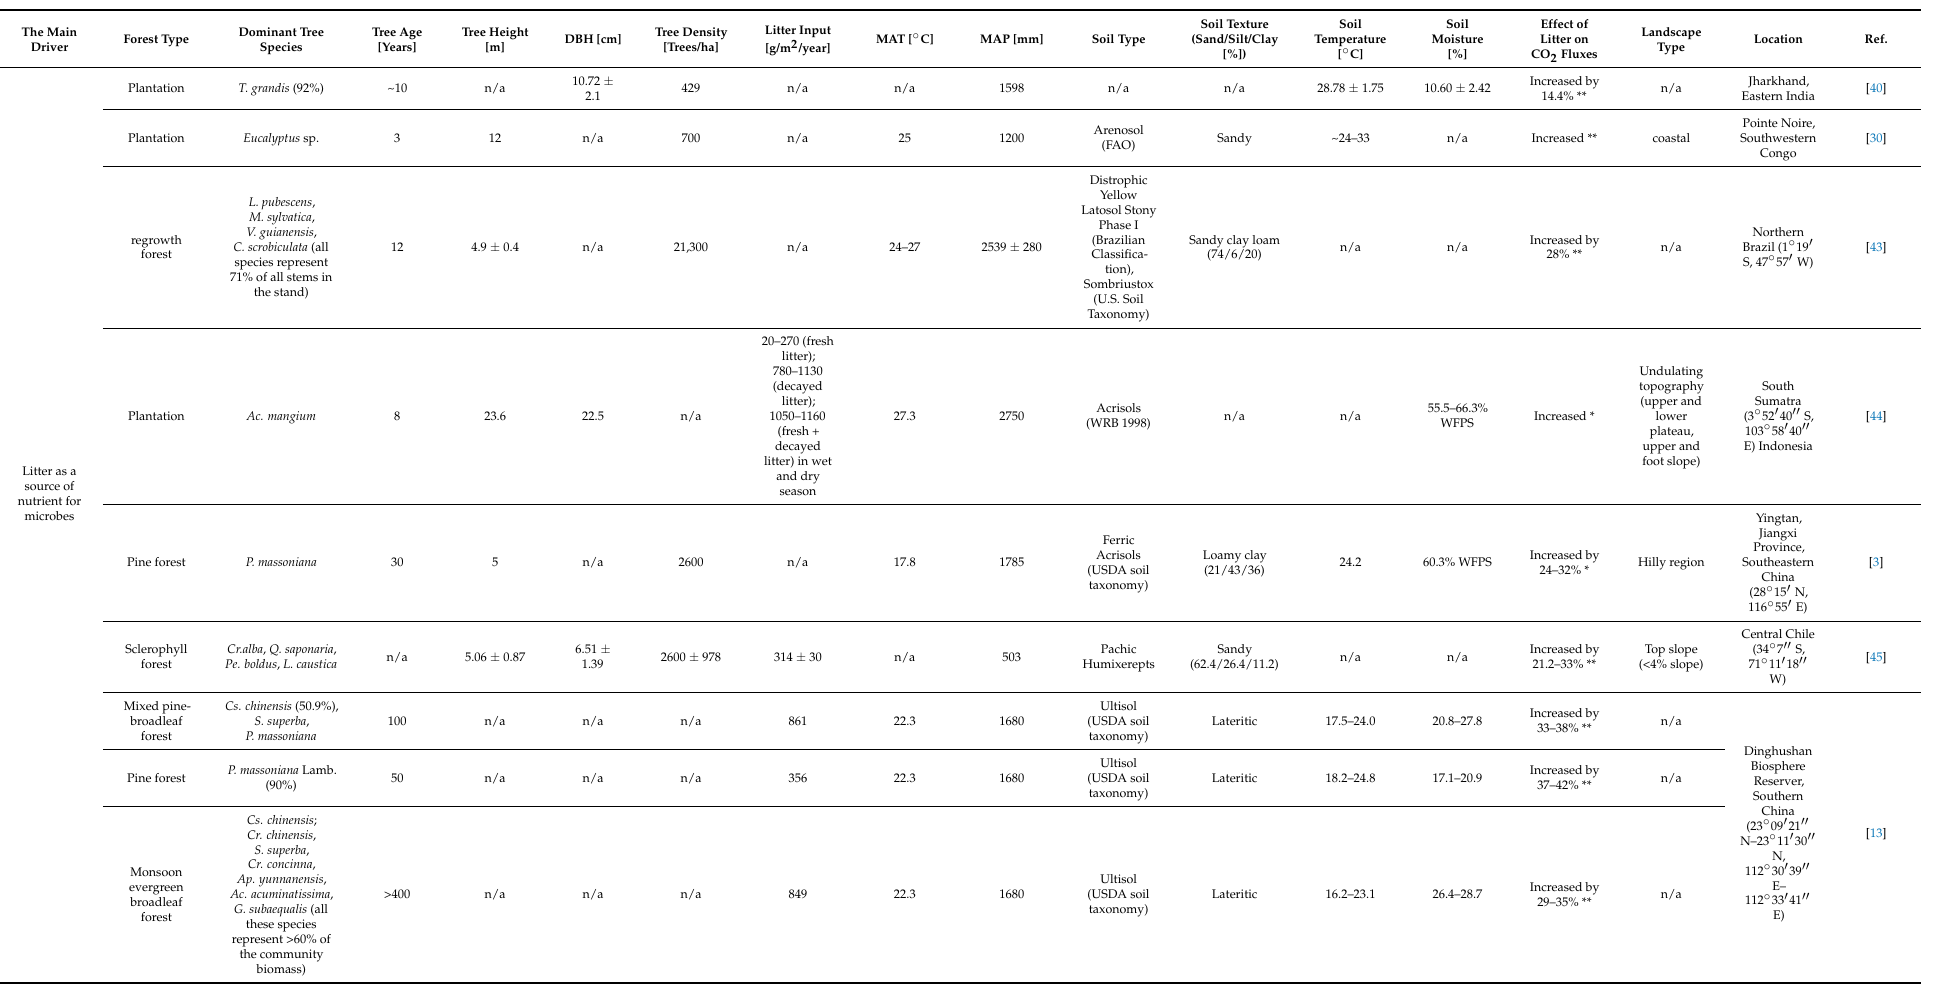
Table 1. The main drivers underlying the effects of litter on CO 2 emission in different forest soils from different regions based on field